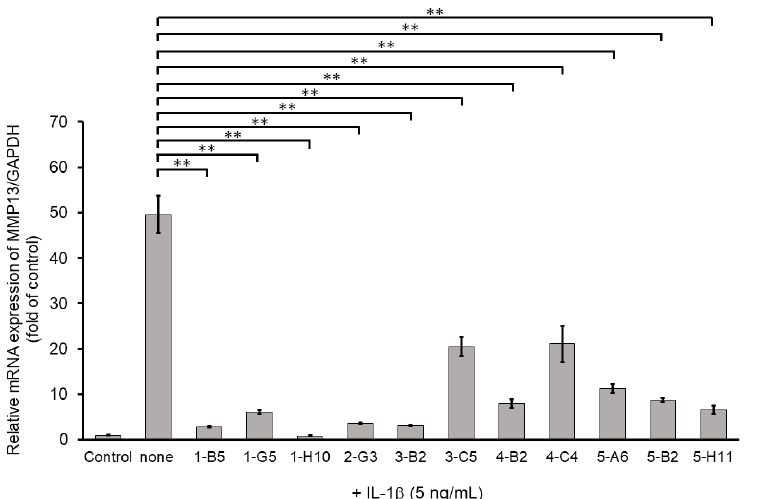
Figure 2. Inhibitory effects of candidate compounds on IL-1 β -induced MMP13 mRNA expression. Cells were treated with each compounds (10 μ g/mL) for 24 h, followed by the stimulation with IL-1 β (5 ng/mL) for 6 h. MMP13 mRNA level was calculated relative to that in uninduced control cells. Values represent mean ± SE ( n = 6 per group). ** p < 0.01.